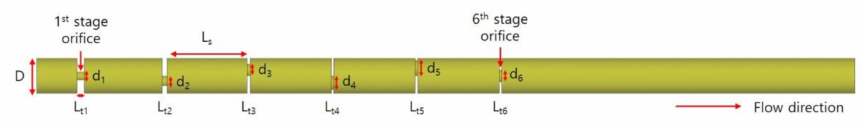
Figure 3. Schematic diagram of the six-stage orifice.